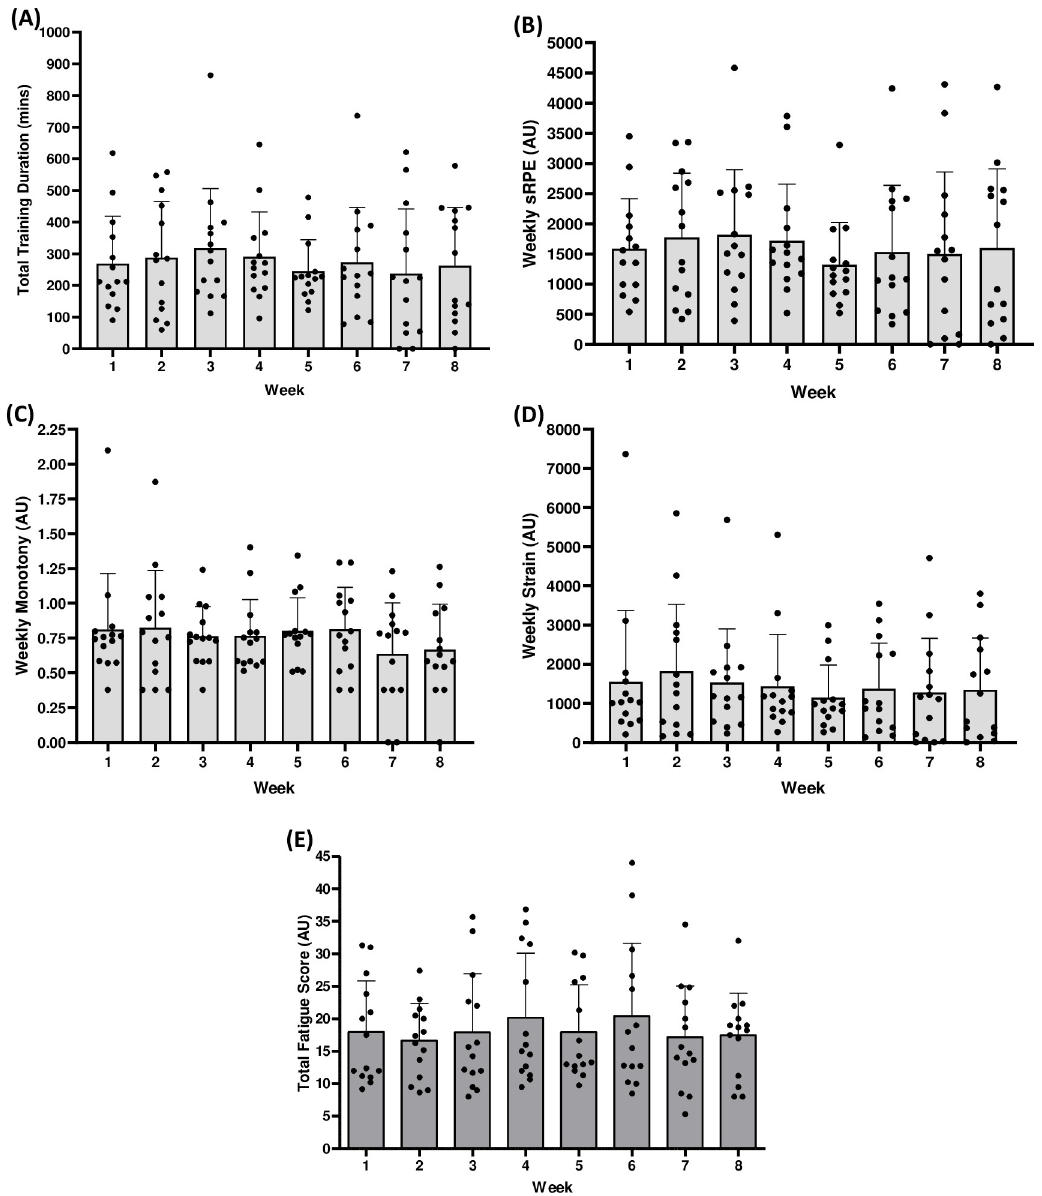
Fig 1. No between week differences in training duration (mins). (a), sRPE (b), monotony (c), strain (d) or total fatigue score (e) (all AU unless stated). Black dots represent individual participants. Error bars =